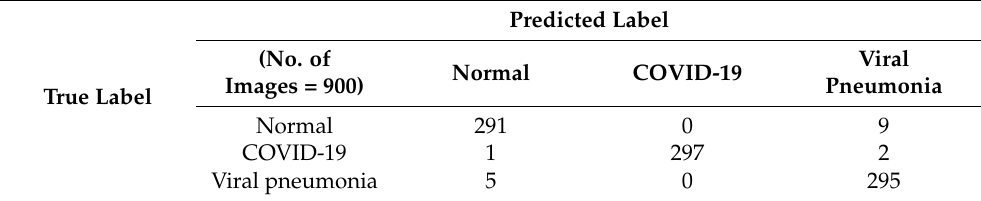
Table 7. Performance metrics of DenseNet201 for three-class